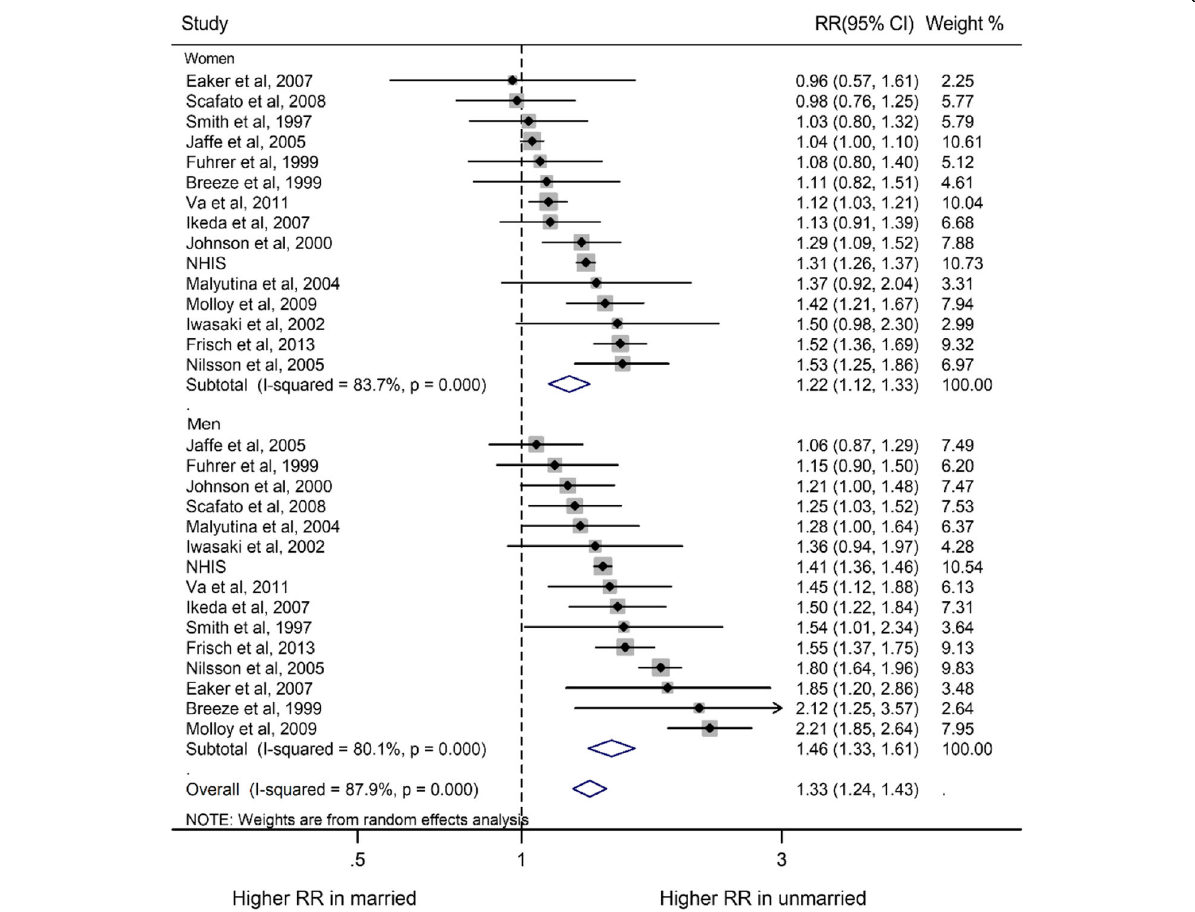
Fig. 2 Sex-specific relative risks (RRs) for all-cause mortality, comparing non-married to married people. The boxes and lines indicate the RRs and their 95% confidence intervals (CIs) on a log scale for each study. The pooled odds ratio is represented by a diamond. The size of the gray squares indicate the relative weight of each